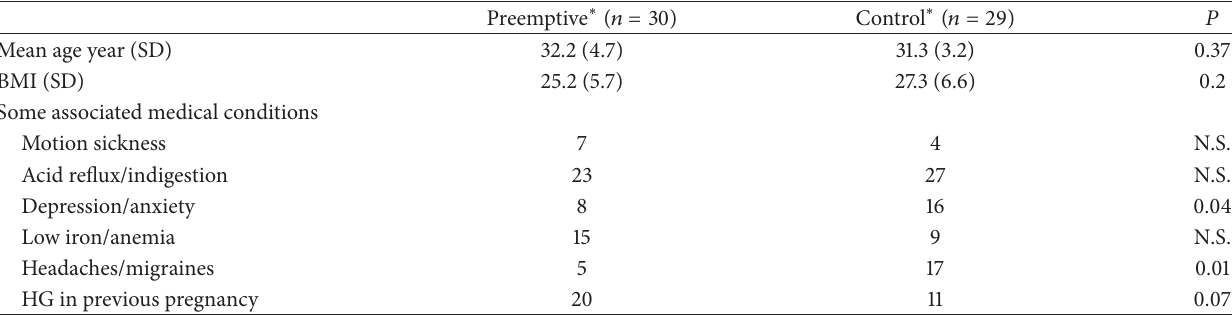
Table 3: Characteristics of the women in the 2